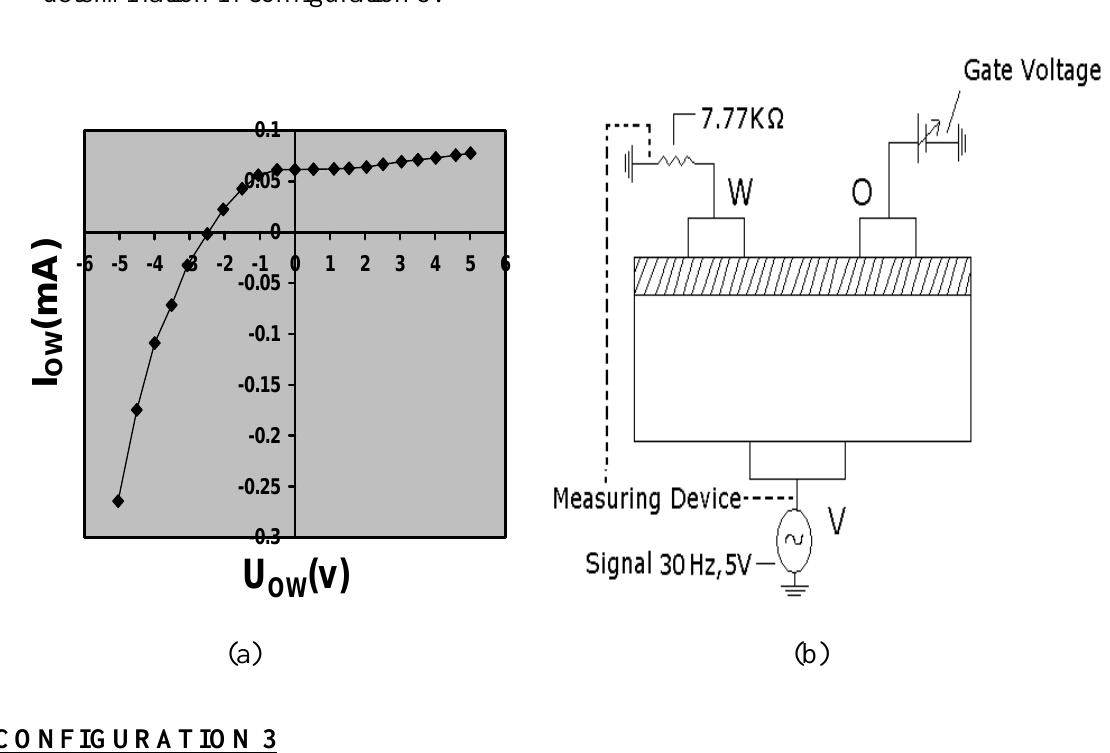
Figure 4. (a) Current/voltage characteristics of PEO:NH structures in configuration 3; (b) the principle measuring setup for current/voltage determination in configuration